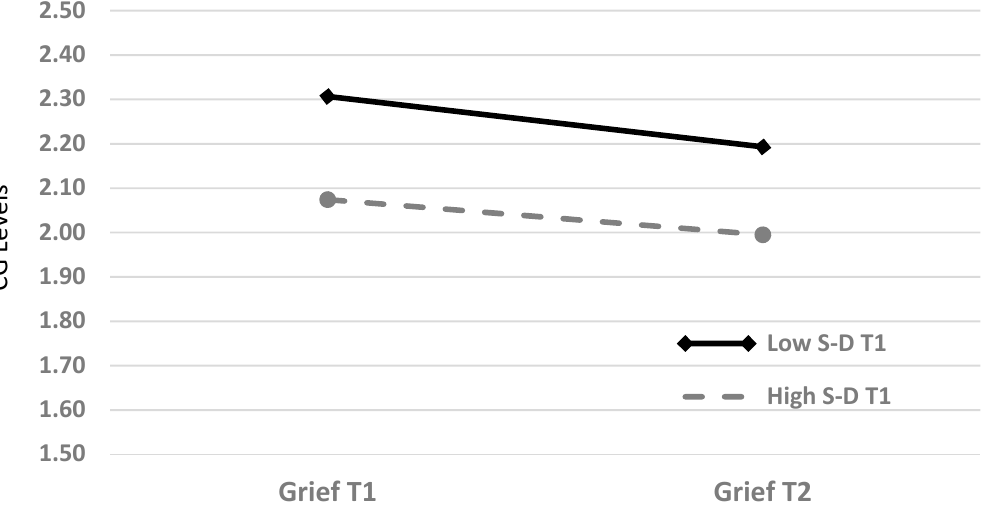
Figure 2. Di ff erences between CG-T1 and CG-T2 as moderated by high and low S-D T1. S-D = self-disclosure; CG = complicated grief.